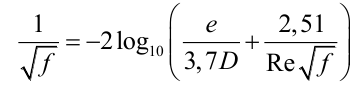
Table 7. Data for convection heat flux coefficient calculation.